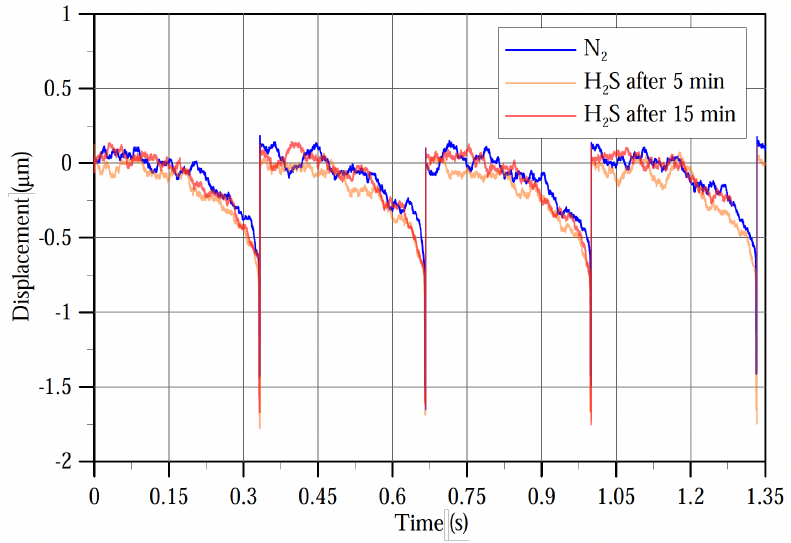
Figure 13. Displacement of the sensor’s tip before and after releasing the gas under a sawtooth signal excitation of 3 Hz